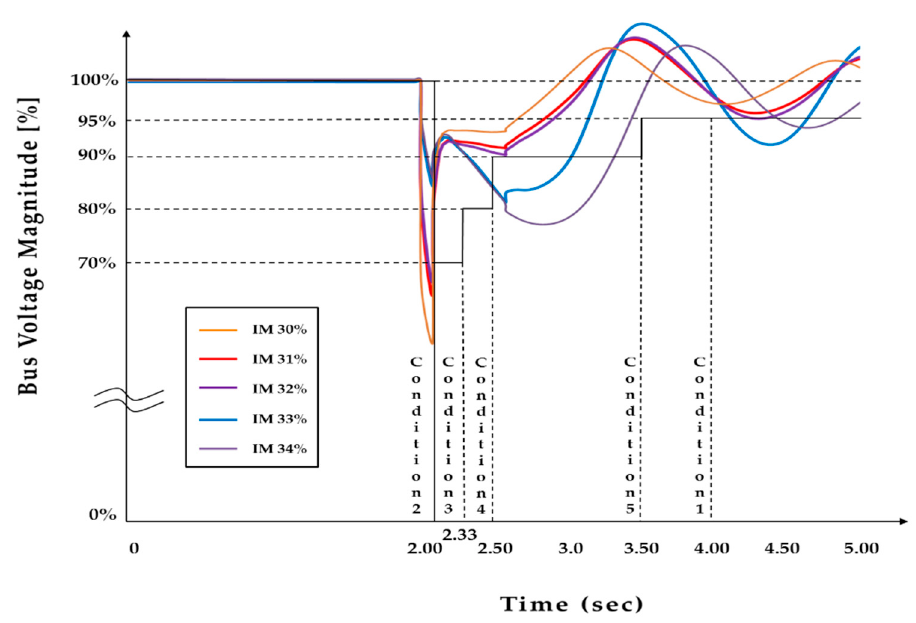
Figure 10. Voltage recovery with MUVLS at severe contingency.